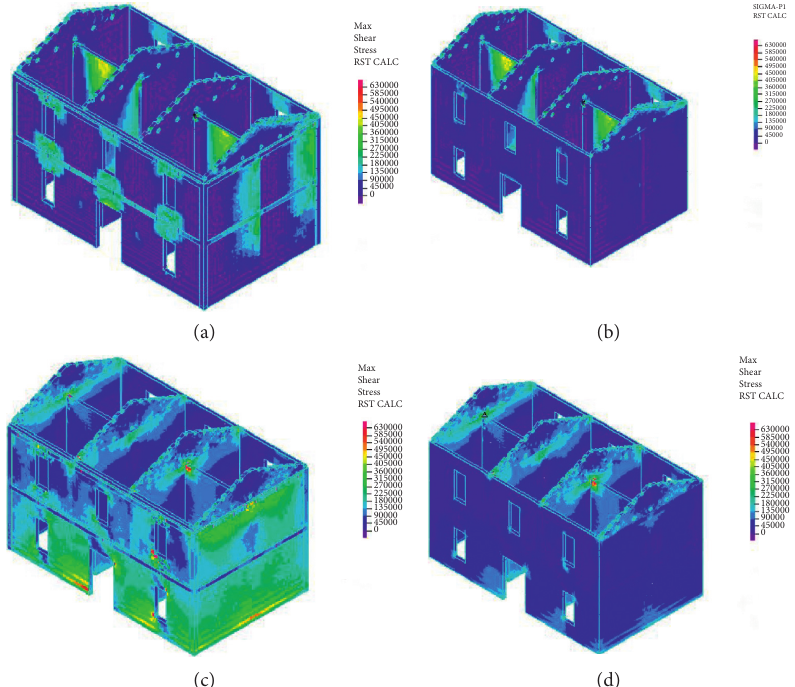
Figure 22: Comparison of stress cloud diagram between the mortar layer and masonry for structures after reinforcement. (a) Main tensile stress of mortar layer. (b) Main tensile stress of masonry. (c) Shear stress of mortar layer. (d) Shear stress of